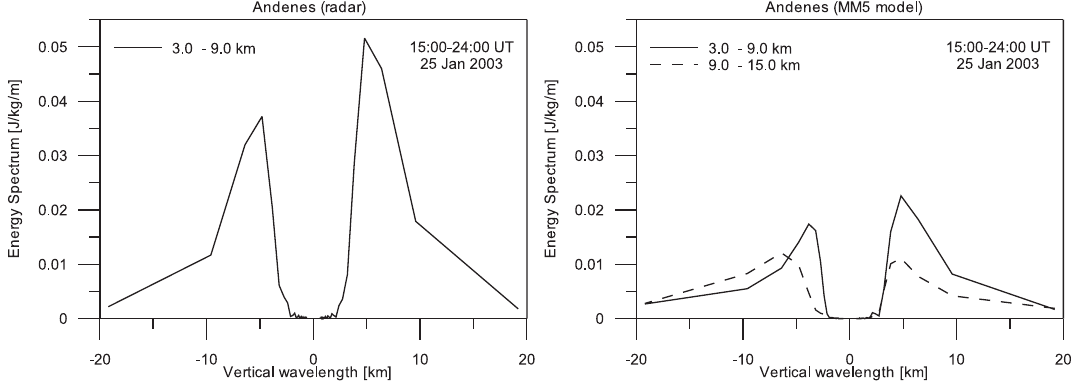
Fig. 7. Rotary spectra derived from vertical profiles of horizontal winds in the height range 3–9km (solid line) and 9–15km (dashed line) at Andenes. The spectra are averaged for 9h starting from 15:00 UT, 25 January 2003. The ALWIN radar data (left) and MM5 model data (right) have been used after band-pass filtering with bandwidth of 8–18h in time and 2–8km in height.